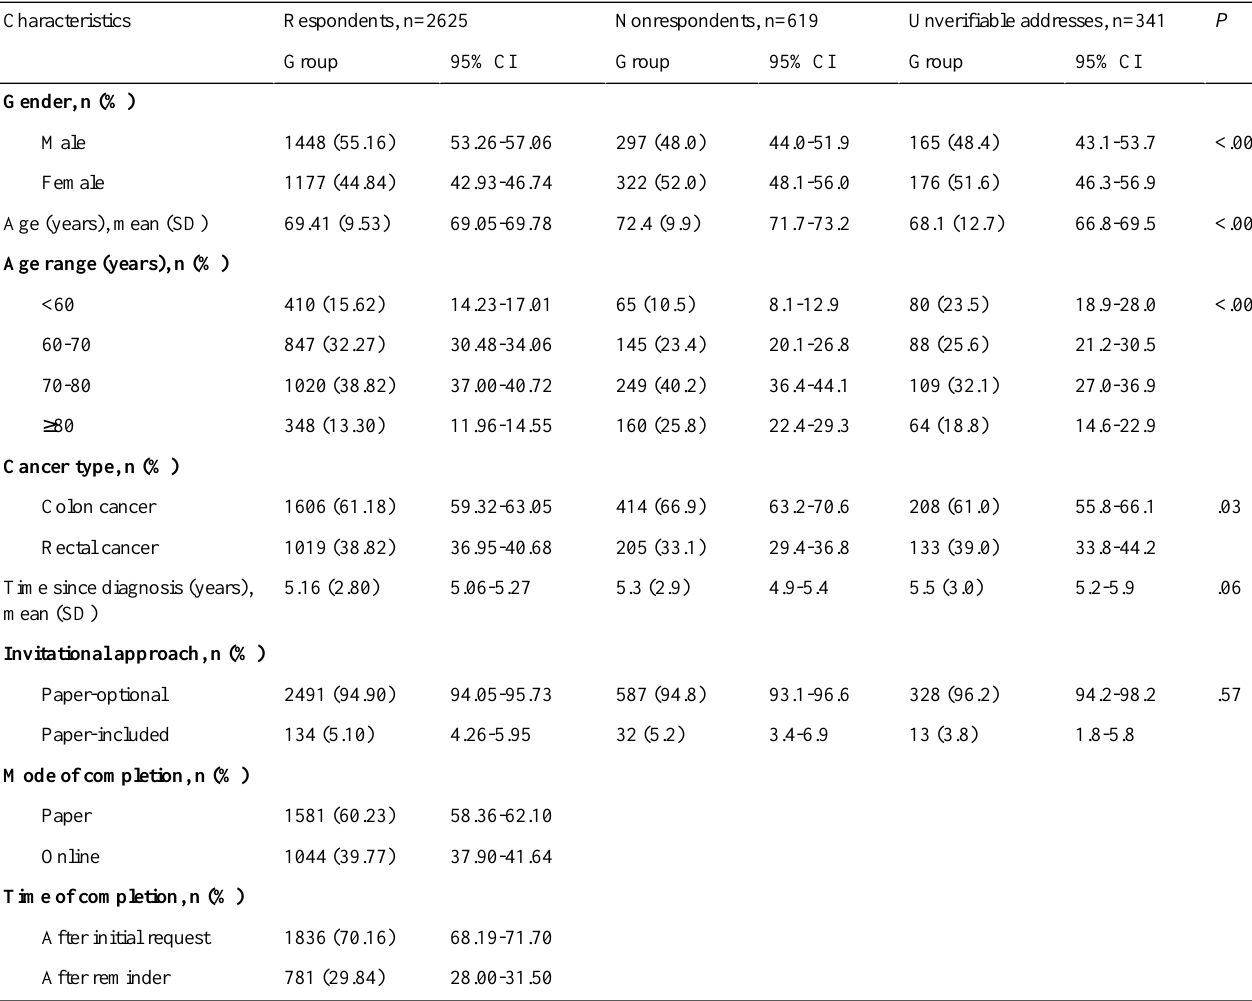
Table 1. Demographic and clinical characteristics of respondents and nonrespondents in a colorectal cancer population.